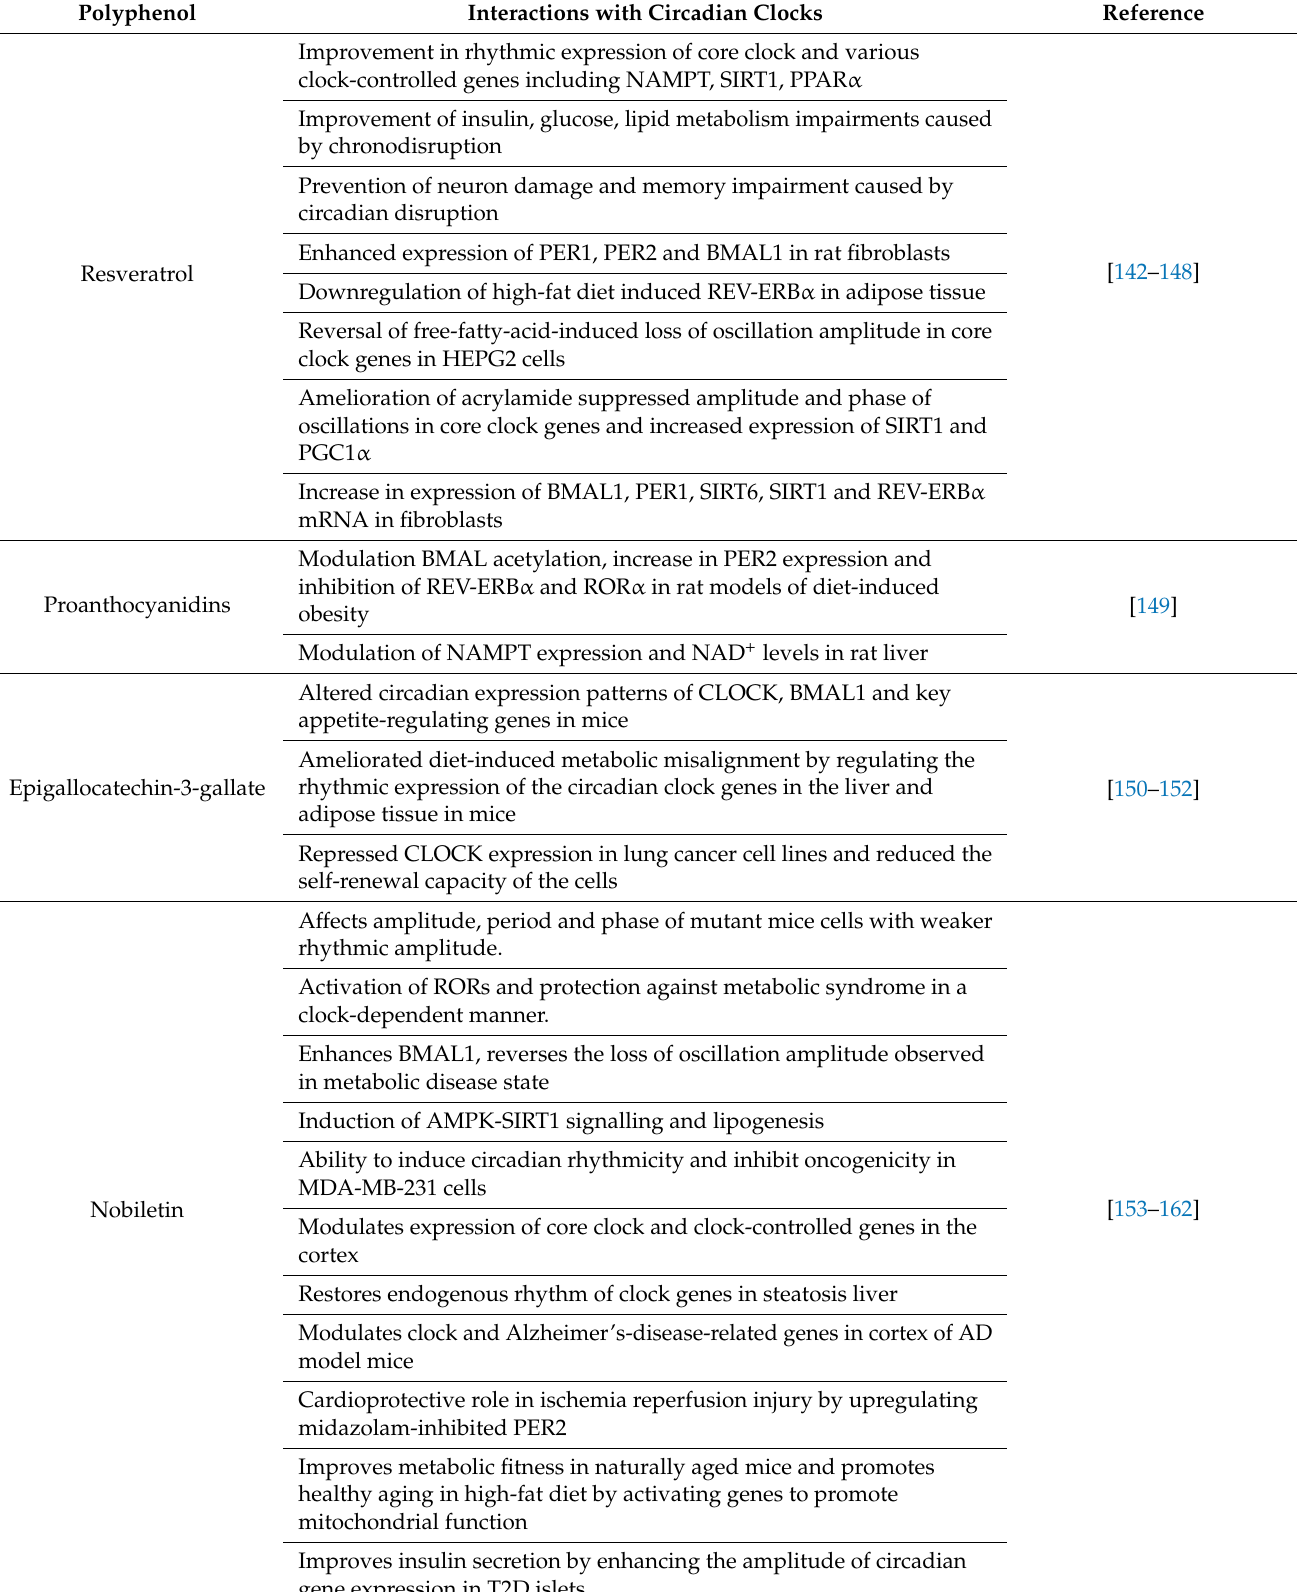
Table 3. A summary of polyphenols with their interactions with circadian system and role in health. Polyphenol Interactions with Circadian Clocks Reference